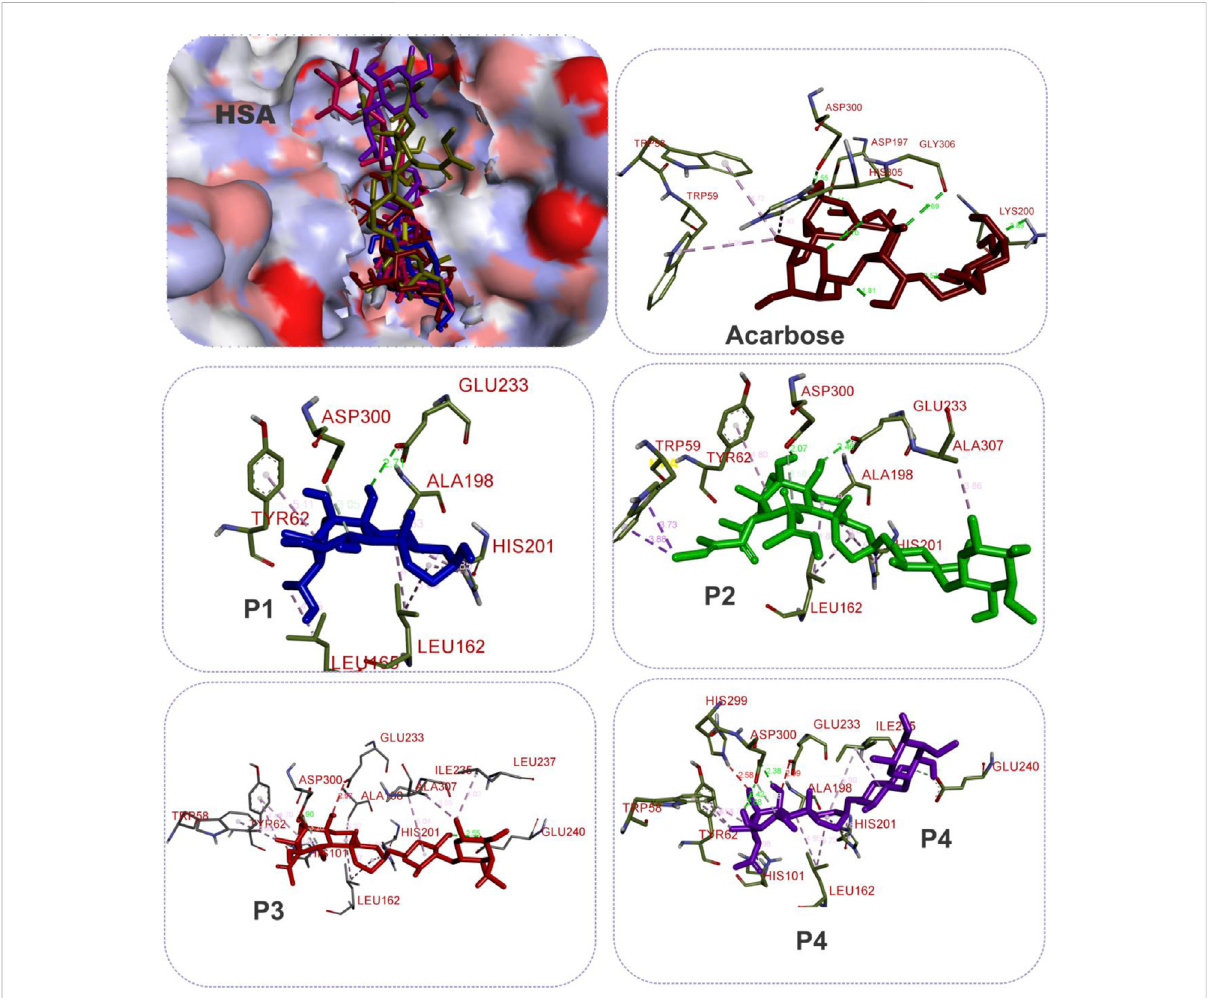
FIGURE 7 The 3D depiction of the interactions of acarbose and the isolated steroidal pregnanes with amino acid residues in the active site of human salivary alpha-amylase (HSA). Ligands are depicted in stick representations in colors red: acarbose (reference inhibitor); blue: P1; green: P2; pink: P3; purple: P4. Interaction types (dotted lines) and their bond lengths are depicted in green (H-bonds); light purple: hydrophobic interactions (pi-Alkyl, alkyl,andpi-stacking);purple:pi-piT-shapedinteractions;yellow:pi-sulfurinteractionsandpi-stackinginteractions.Aminoacidresiduesarein a three-letter